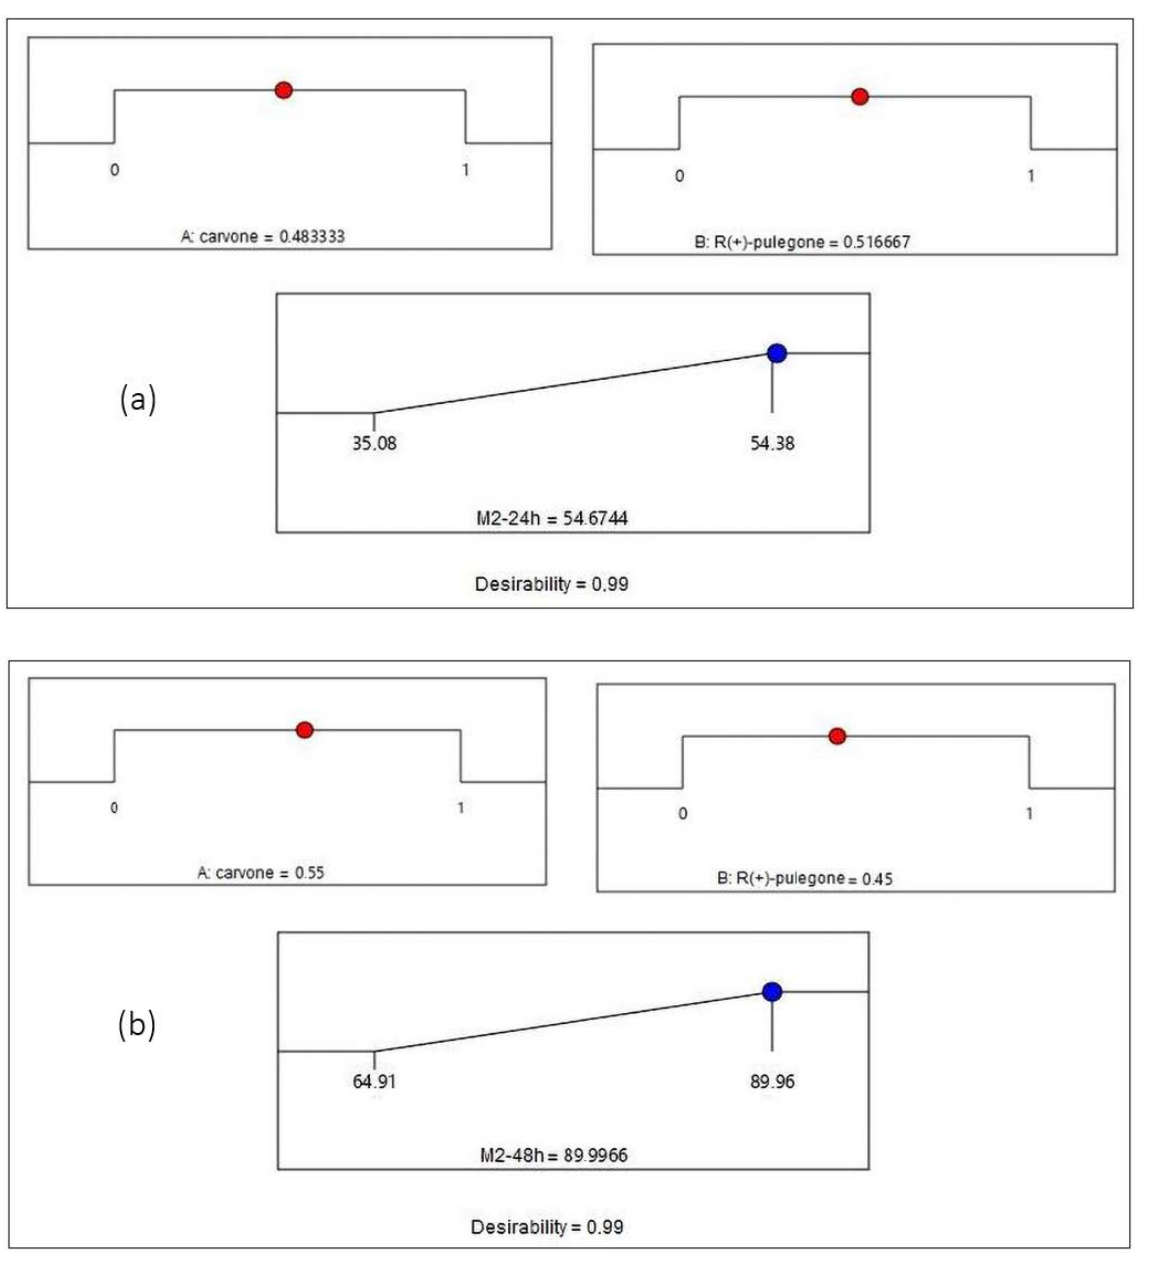
Figure 5. Desirability profile of optimal conditions to maximize the mortality rate for Mixture 2 ( a ) at 24 h and ( b ) at 48 h. (A) carvone; (B) R (+)-pulegone.